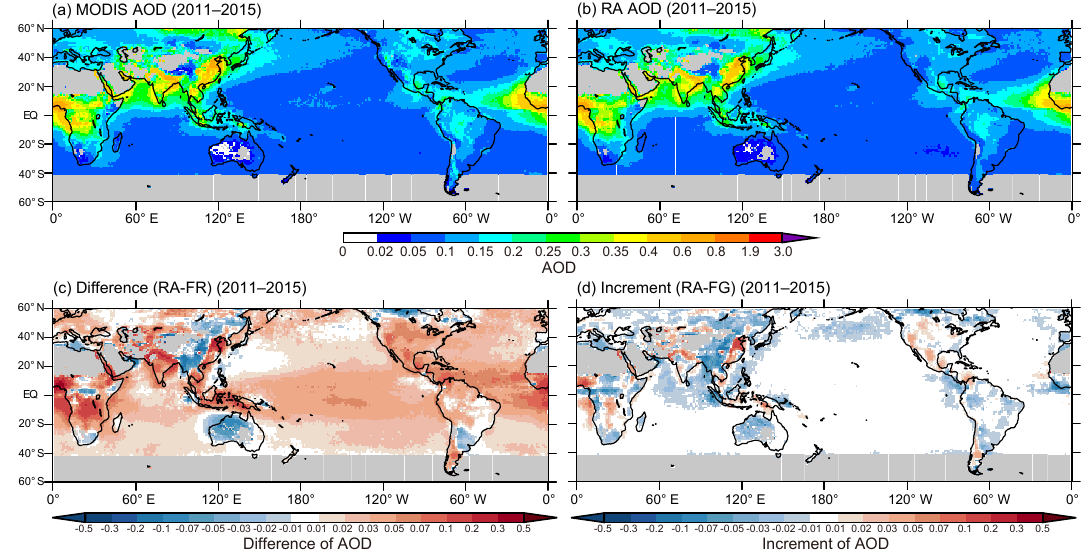
Figure 6. Spatial distributions of 5-year averaged AODs during 2011–2015: (a) NRL-UND MODIS, (b) RA, (c) difference (RA minus FR), and (d) increment (RA minus FG). No observation data were available from gray areas (also see Fig.